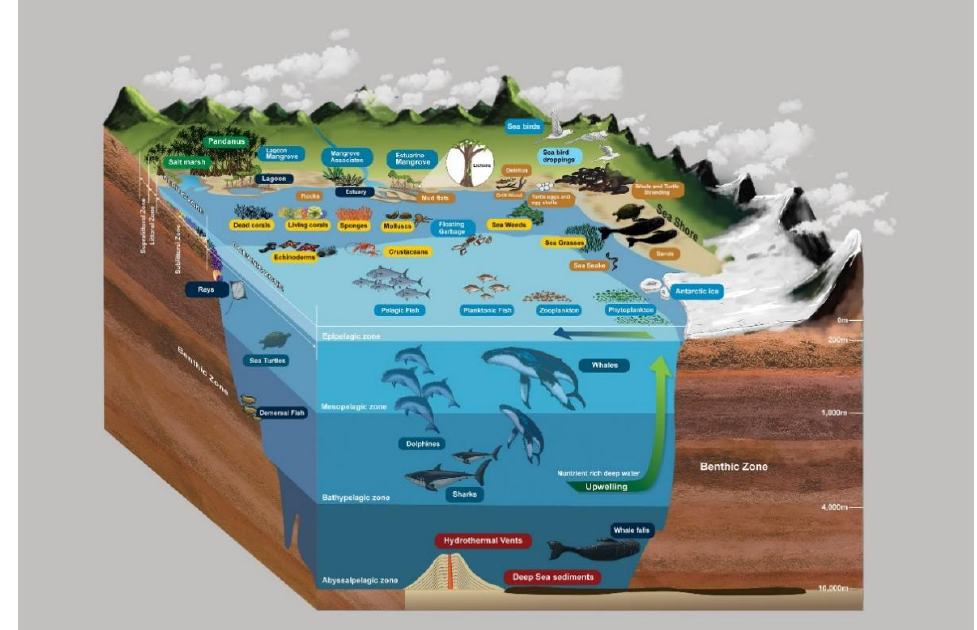
Figure 3. Different habitats and ecosystems for marine fungi.